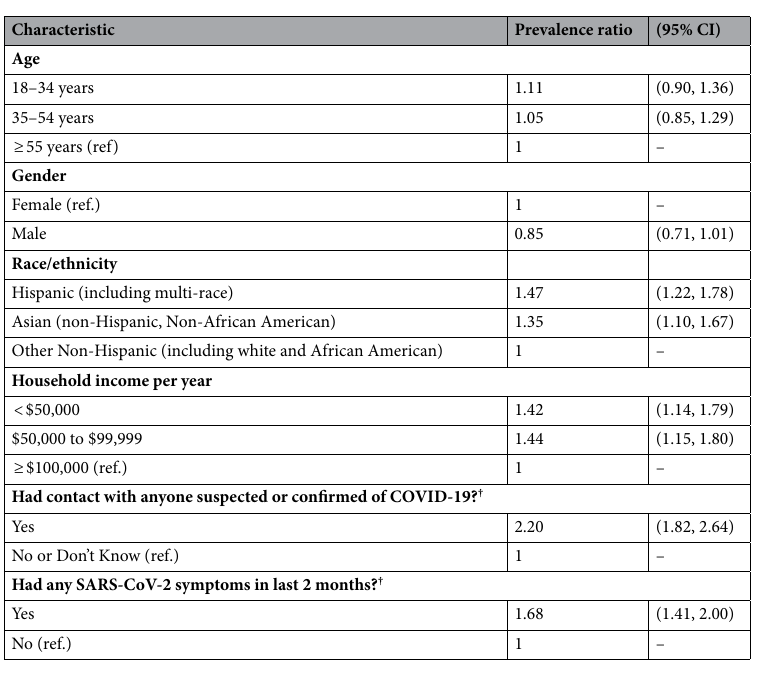
Table 2. Adjusted* SARS-CoV-2 seroprevalence ratios among adults in Orange County, CA, July 10th to August 16th, 2020. *Estimates use population weights and adjust for age, gender, income, race/ethnicity, and sampling week. † Effects of suspected contact or symptoms are estimated in separate models.